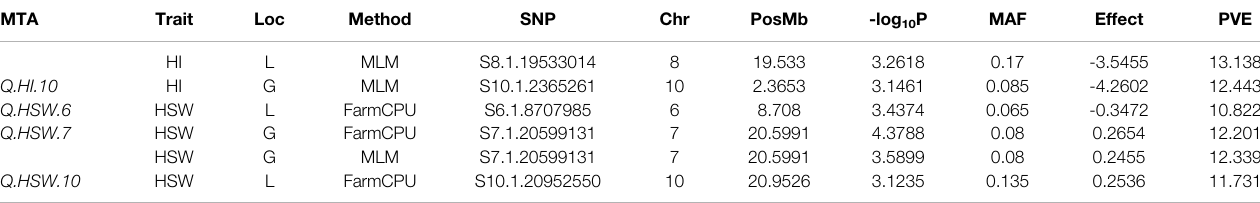
alternative allele was found to be superior at Gurdaspur. Allelic